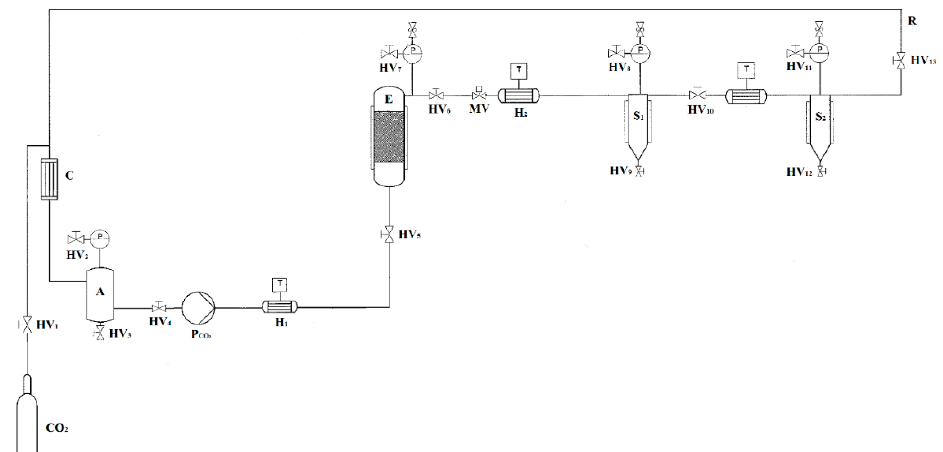
Figure 4. Flowsheet of the supercritical carbon dioxide pilot scale apparatus. CO 2 : storage tank; E: extraction vessel; S#: separators; H#: heat exchangers; C: condenser; HV#: hand valves; MV: membrane valve; P CO2 : diaphragm pump; T: thermocouples; P#: manometers; R: CO 2 recirculation; A: liquid storage tank.